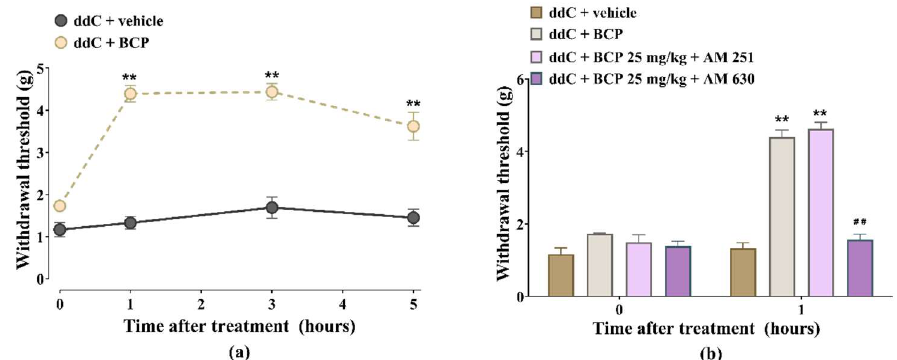
Figure 3. Antiallodynic effects of β-caryophyllene (BCP) against established 2′-3′-dideoxycytidine (ddC)-induced mechanical allodynia in female BALB/c mice is antagonized by CB2, but not CB1, receptor antagonist. ( a ) Acute antiallodynic effects of BCP 25 mg/kg on mice with established ddC-induced mechanical allodynia. β-Caryophyllene was administered at day 7 post-first-injection of ddC. Mechanical sensitivity was measured by dynamic plantar aesthesiometer. Each point represents the mean ± SEM of values obtained from four animals. ** p < 0.01 compared to mice treated with ddC + vehicle. ( b ) E ff ects of AM 251, a CB1 receptor antagonist, and AM 630, a CB2 receptor antagonist, on the antiallodynic e ff ects of BCP on mice with ddC-induced mechanical allodynia 1 h after administration. Each bar represents the mean ± SEM of values obtained from four animals. ** p < 0.01 compared to mice treated with ddC + vehicle and ## p < 0.01 compared to mice treated with ddC + BCP (two-way repeated measures ANOVA followed by Sidak’s multiple comparisons